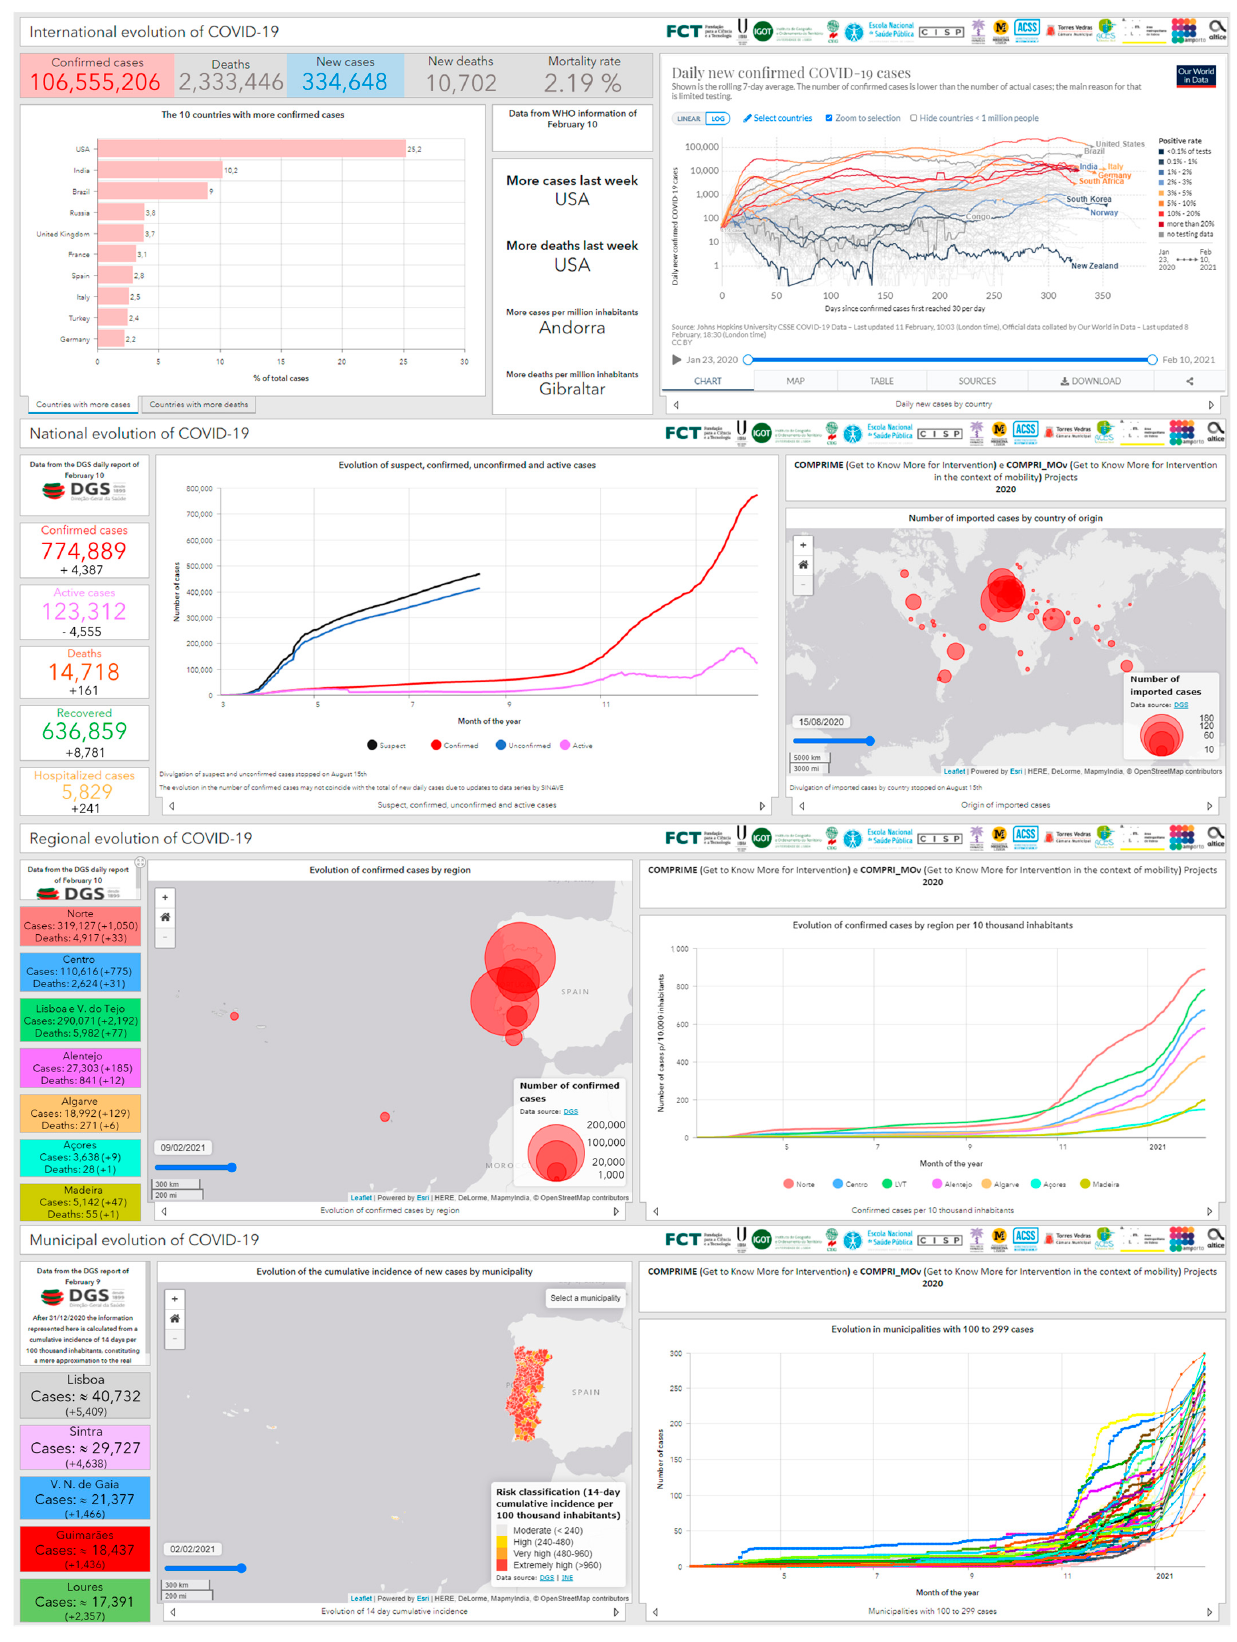
Figure 2 - Dashboard design. Figure 2. Dashboard